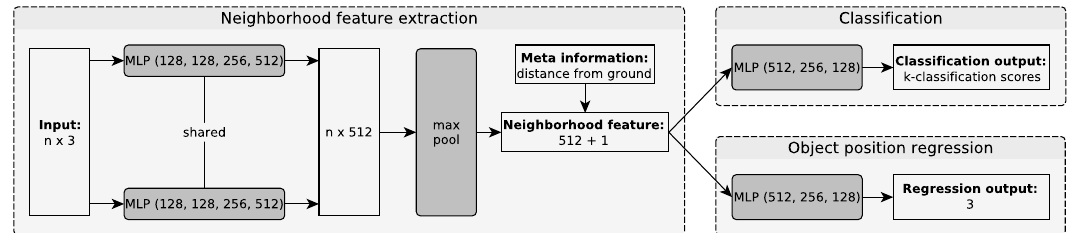
Figure 2. Topology of the neural network. The main input are the n 3D points of a local point neighborhood. The distance from ground to the center point of the processed local point neighborhood is added after the feature extraction to enrich the neighborhood feature. Outputs are classification scores for k classes and estimated 3D coordinates of the object’s center. Batch normalization is used for all MLP ( muli-layer perceptron ) layers, except for the layer directly before the output layer. The last batch normalization of each output is followed by a dropout layer with a dropout rate of